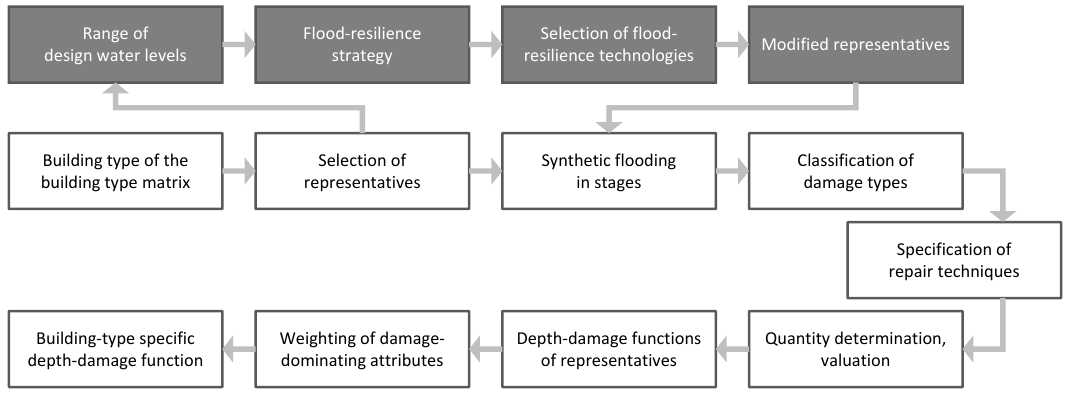
Figure 2. Extended method for calculating synthetic depth-damage functions considering the effects of FReT ([33,35],